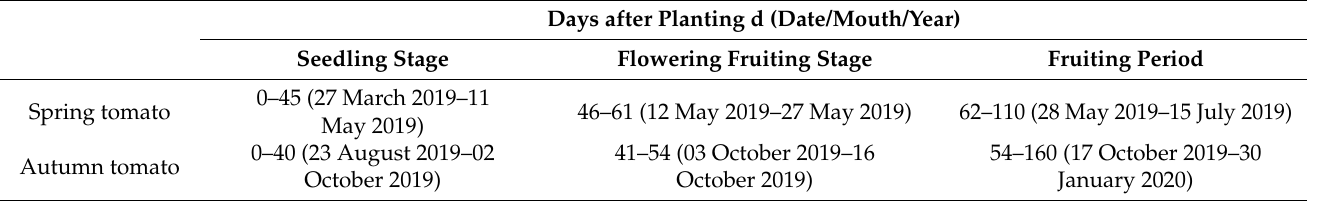
Table 1. Division of tomato growth period. Days after Planting d (Date/Mouth/Year) Flowering Fruiting Stage Fruiting